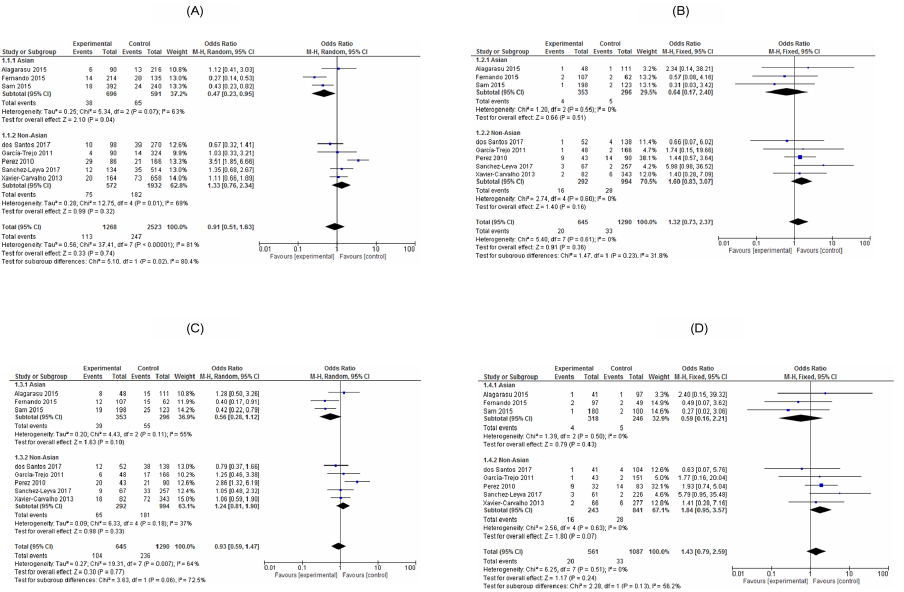
Fig 2. Forest plot of the associated TNF- α -308G > A and dengue haemorrhagic fever (A: Allele contrast model, B: Recessive model, C: Dominant model, D: Additive model).